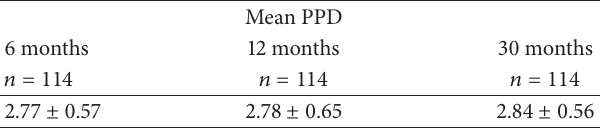
Table 3: Mean PPD values in mm ( 𝑛 : number of implants). Mean PPD